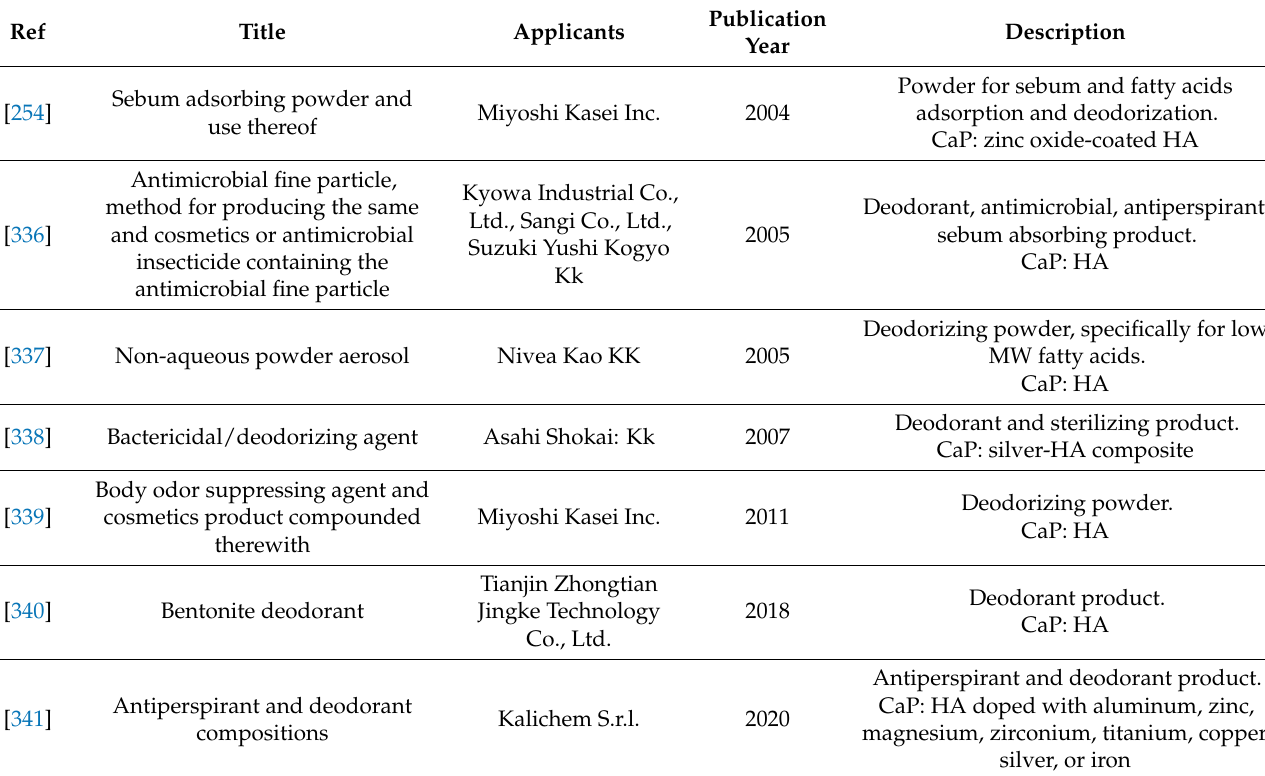
Table 7. List of patents about calcium phosphates as